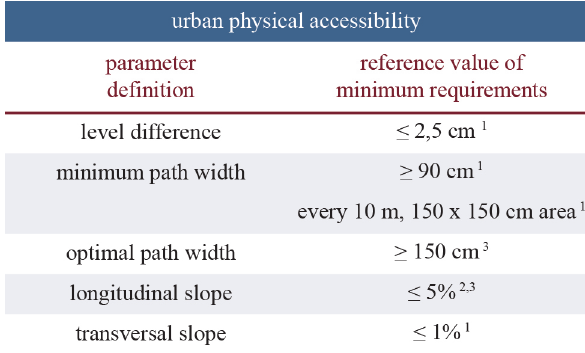
Table 1. Proposed parameters for the assess of urban physical accessibility. Sources are 1: Italian regulation, 2: Lombardy Region regulation, 3: literature and empirical